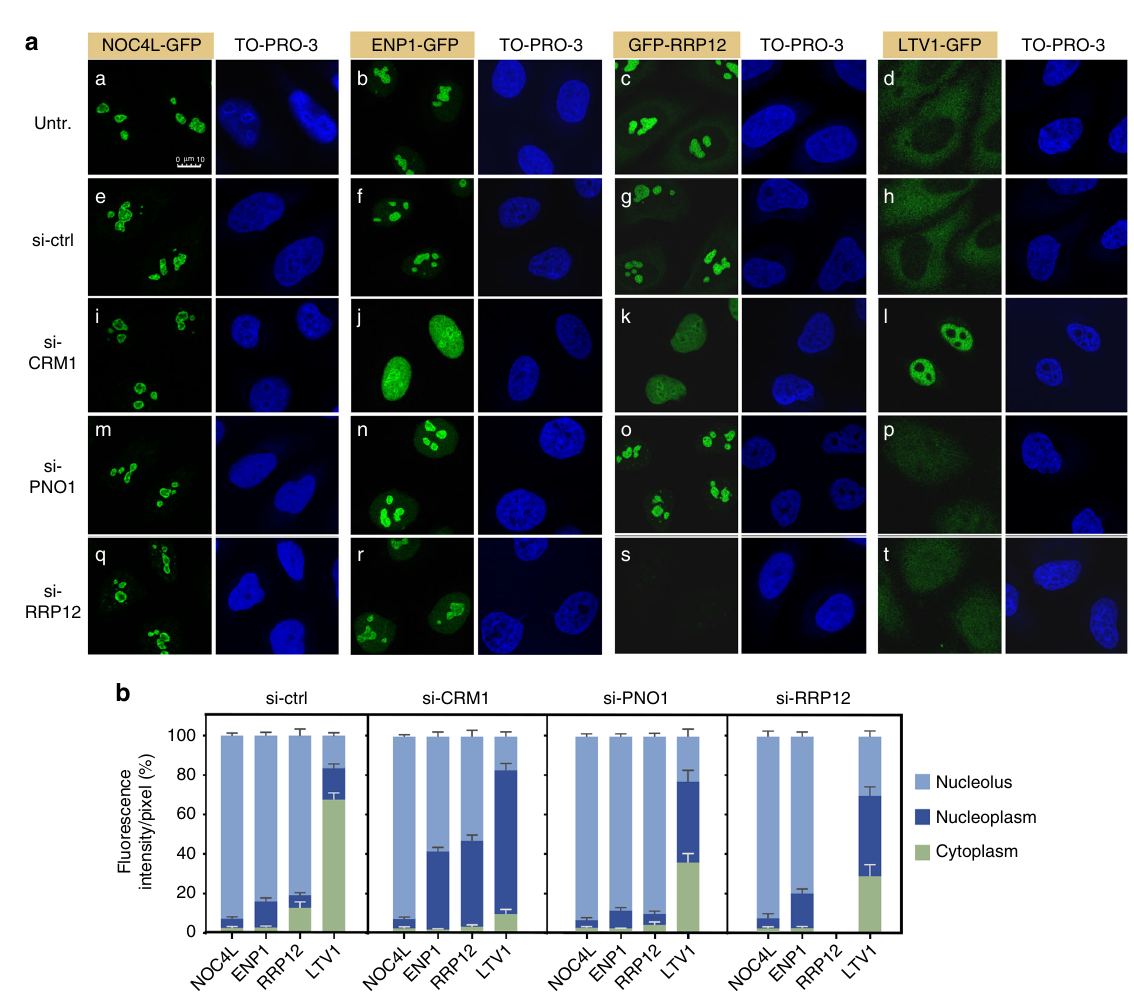
Fig. 5 RRP12 is required for the generation of export-competent pre-40S precursors in the nucleoplasm. a Subcellular localization of NOC4L-GFP, ENP1- GFP, GFP-RRP12, and LTV1-GFP in CRM1-, PNO1- and RRP12-depleted cells. si-ctrl, siRNA control without target. b Quanti fi cation of the experiment shown in a . Relative ratios of average fl uorescence intensities in the nucleolus, nucleoplasm and cytoplasm were calculated for individual cells. Data are the mean ± s.d. from 30 cells of each condition in experimental duplicates. Source data are provided as a Source Data fi show that PNO1 is essential for the emergence of pre-40S particles.